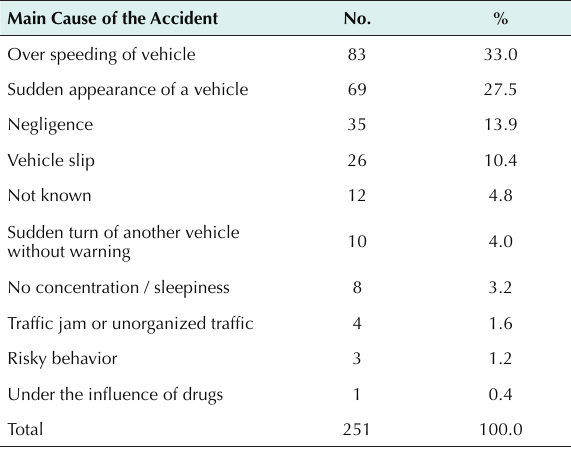
Table 6. Distribution of RTA Victims According to Main Causes of the Accident Main Cause of the